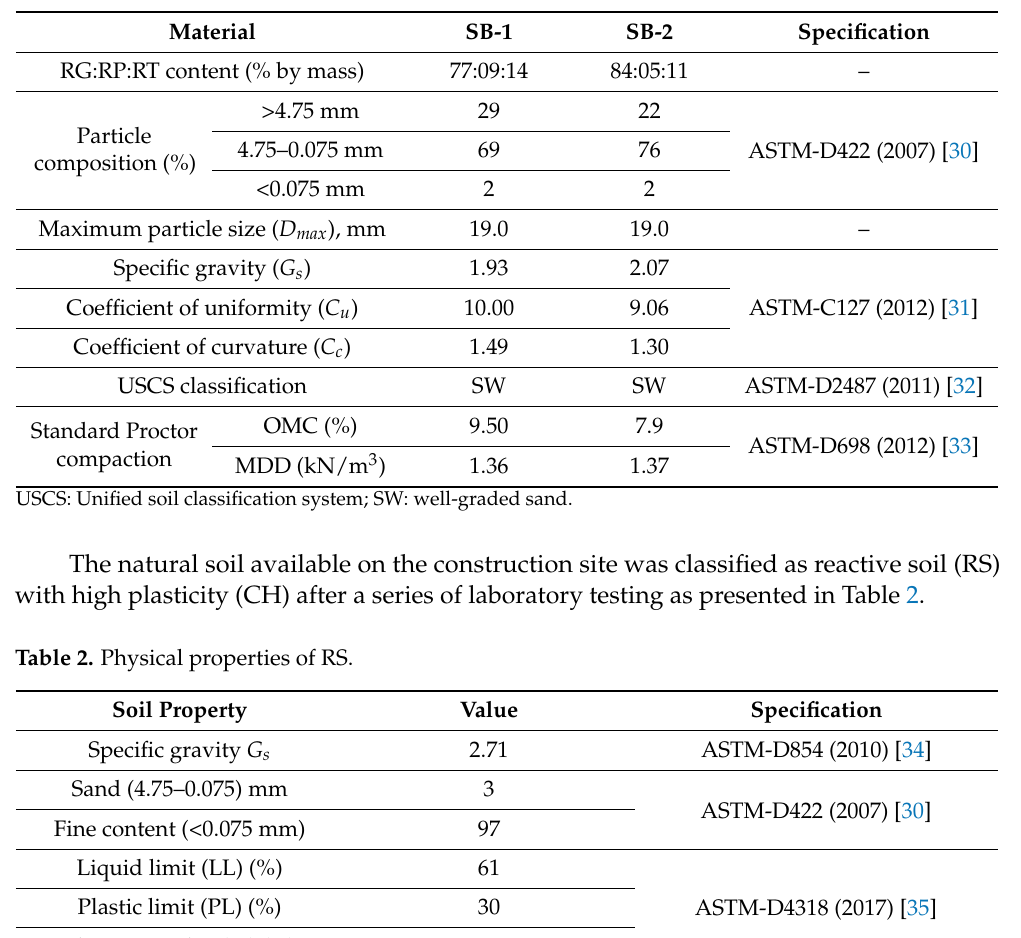
Table 1. Physical properties of SB-1 and SB-2 blends.